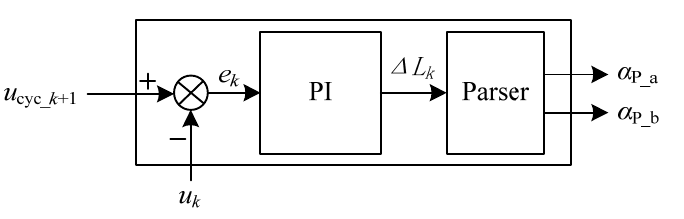
Figure 3. Schematic of the driver